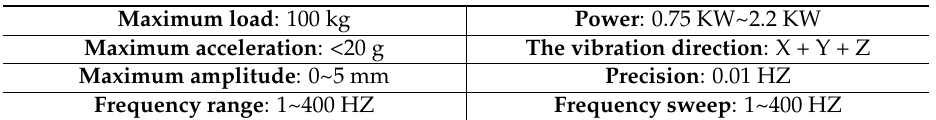
Table 2. Parameters of the electromagnetic vibrators.